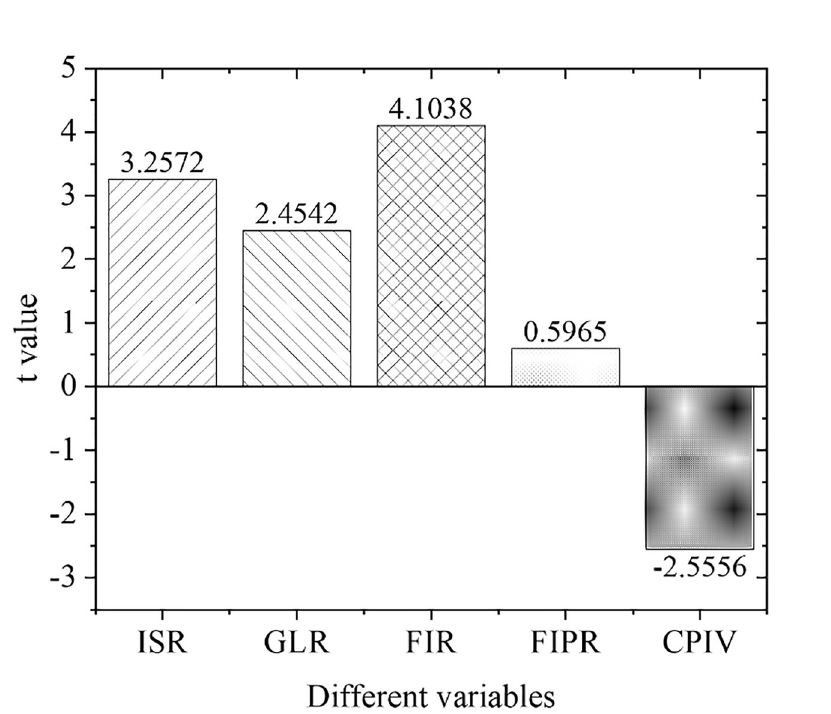
Fig 8. Calculation results of t value in the eastern region.